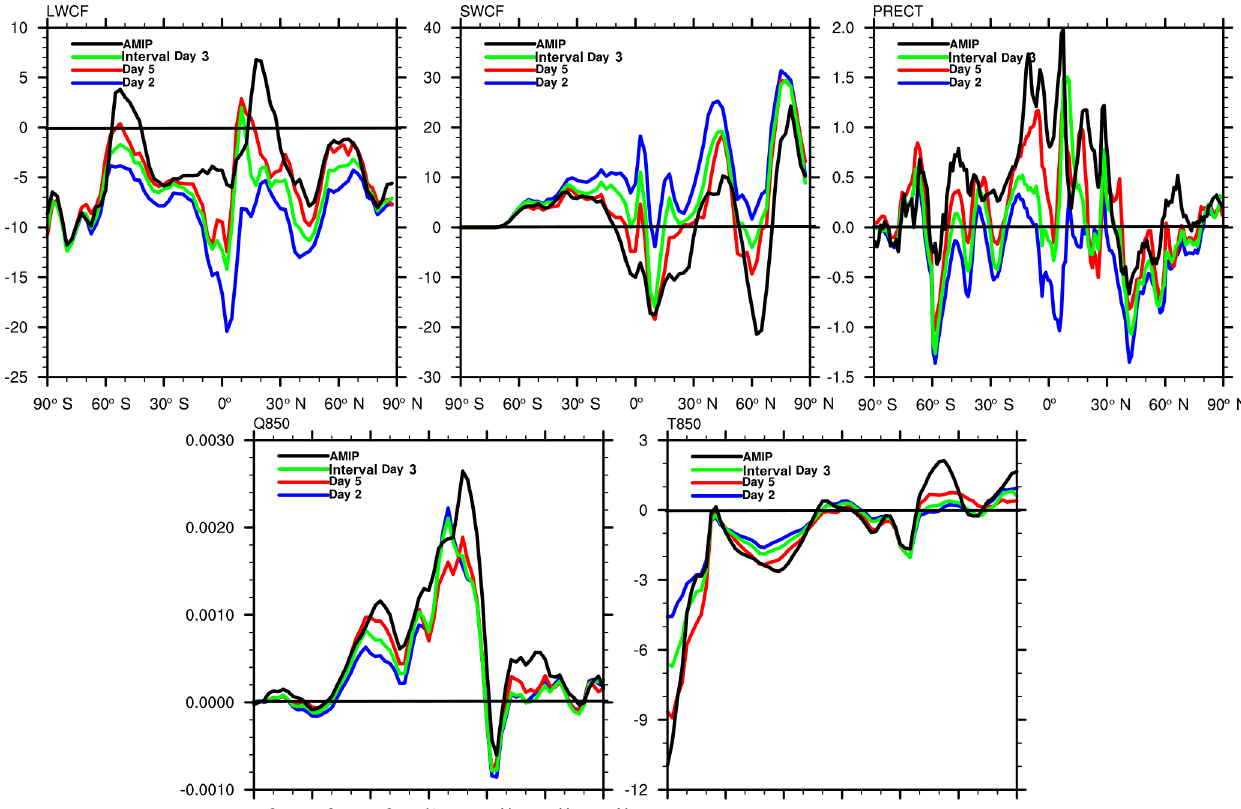
Figure 1. The comparison between short-term hindcasts and long-term Atmospheric Model Intercomparison Project (AMIP). The y axis shows bias between the simulations and the observations. The black line is the July mean state from 2000 to 2004 of AMIP simulations. The blue, red, and green lines represent the second day hindcast (labeled as Day 2), the fifth day hindcast (labeled as Day 5), and the Interval Day 3 hindcasts, respectively, for July